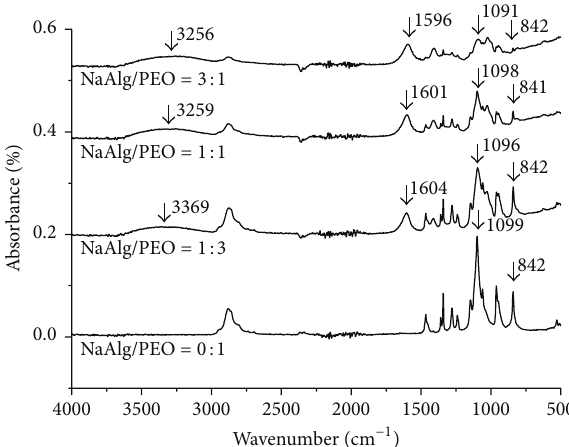
Figure 6: The FTIR spectra of alginate-based nanofibers with different NaAlg/PEO ratios.